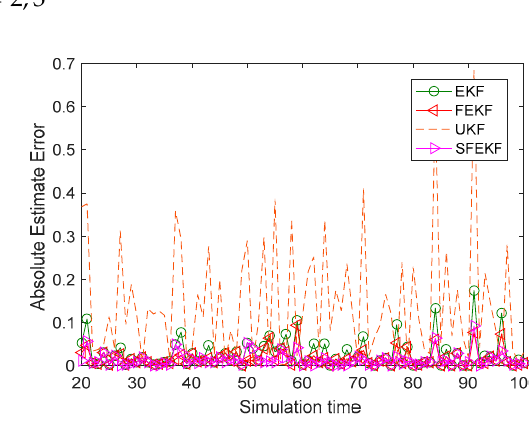
Figure 2. The absolute error curves of the four methods.